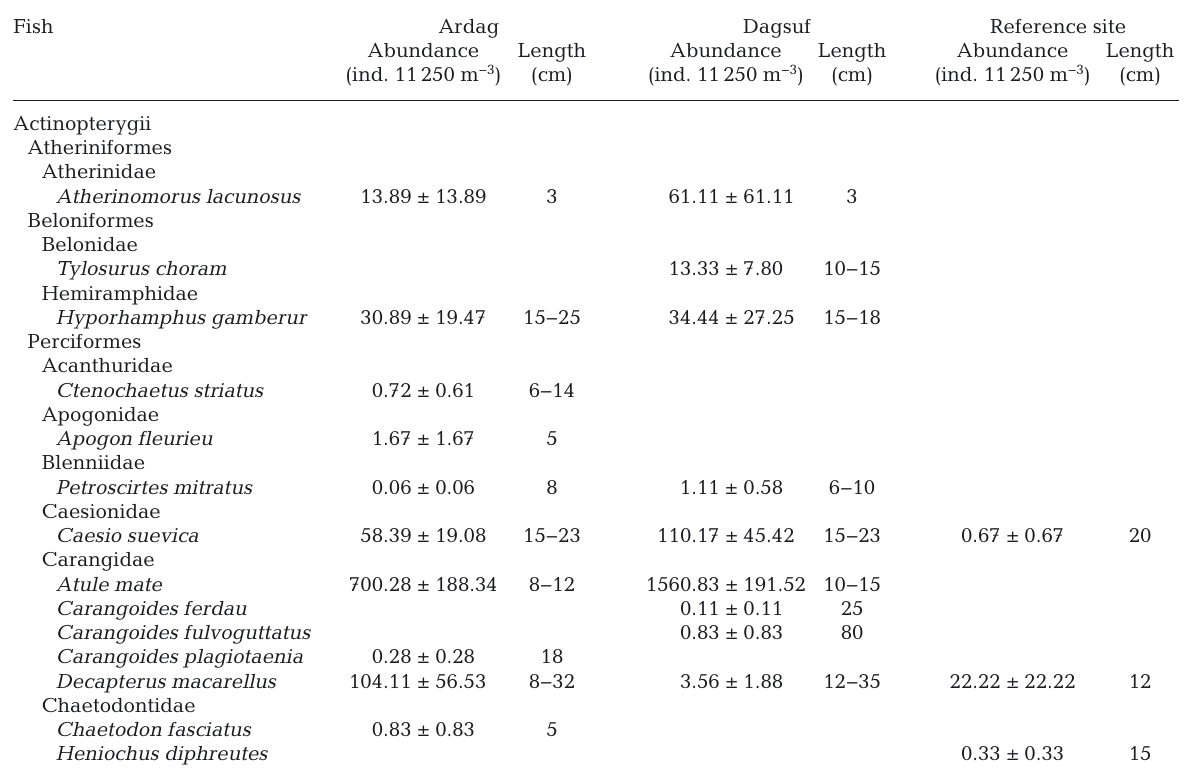
Table 2. Abundance (mean ± SE) and body length (or range of lengths) of wild fish species for the 3 sampling dates at the fish farms and reference site. Values are from 18 rapid visual counts. Blank: not